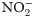
Regulatory network of denitrification in Pa. denitrificans.The network is driven by four core enzyme-complexes: Nar (transmembrane nitrate reductase encoded by the narG gene), NirS (cytochrome cd
1 nitrite reductase encoded by nirS), cNor (NO reductase encoded by norBC), and NosZ (N2O reductase encoded by nosZ). When anoxia is imminent, the low [O2] is sensed by FnrP, which in some interplay with NarR induces nar transcription. NarR is activated by NO2−; thus once a cell starts producing traces of NO2−, nar expression becomes autocatalytic (see P1). Transcription of nirS is induced by NNR, which is activated under anoxic/micro-oxic conditions by NO; thus once traces of NO are produced, the expression of nirS also becomes autocatalytic (see P2) [20]. The activated P2 will also induce nor and nosZ transcription via NNR. The transcription of nosZ, however, can also be induced equally and independently by FnrP [24]. Micromolar concentrations of NO may inactivate both FnrP [25] and NosZ [26]. These observations, however, are ignored for our modelling because Pa. denitrificans restricts NO to nanomolar levels.